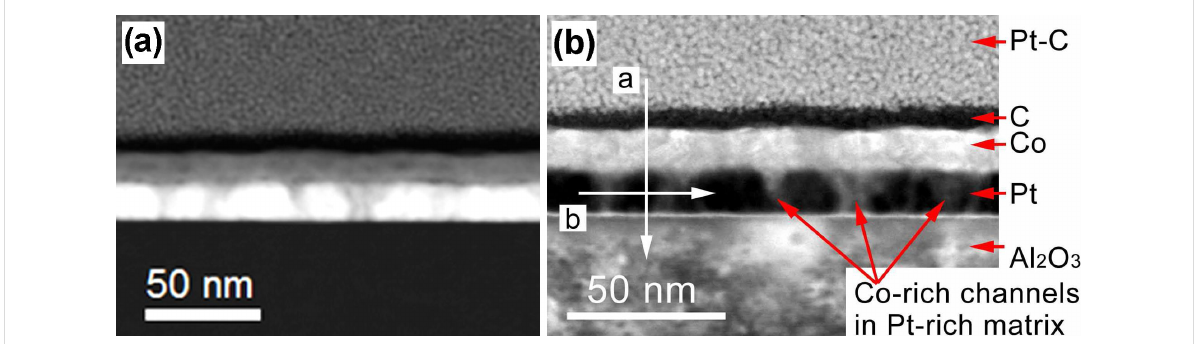
Figure 5: TEM micrographs of sample C acquired (a) in the high angle annular dark field mode and (b) in the annular dark field mode. In (a), elements with higher atomic numbers Z are brighter in the image. The light regions in the Pt layer in (b) correspond to Co-rich channels embedded in the Pt-rich matrix. The arrows depict the directions along which the STEM-EDX elemental peak intensities in Figure 6 have been acquired.